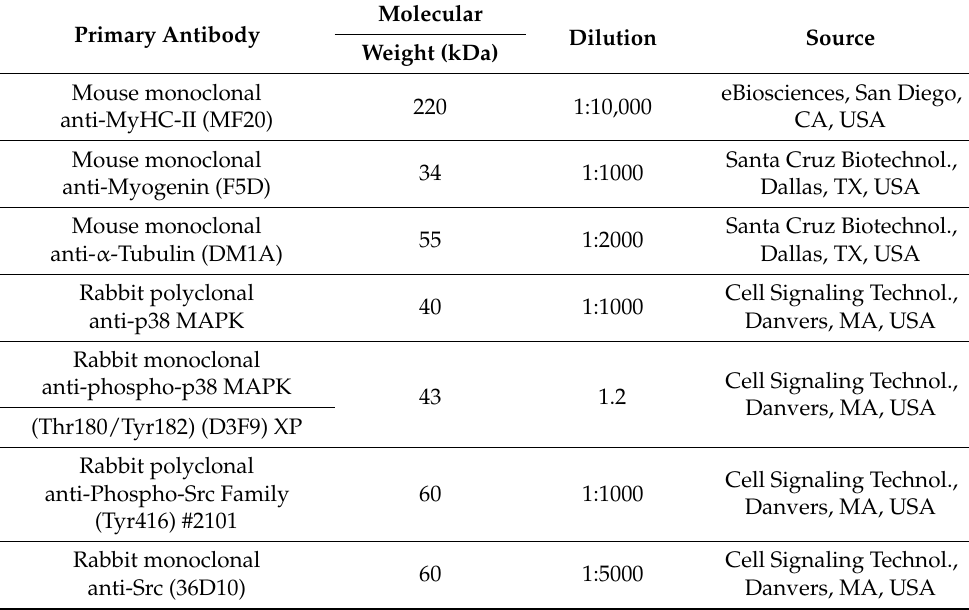
Table 2. List of primary and secondary antibodies used in